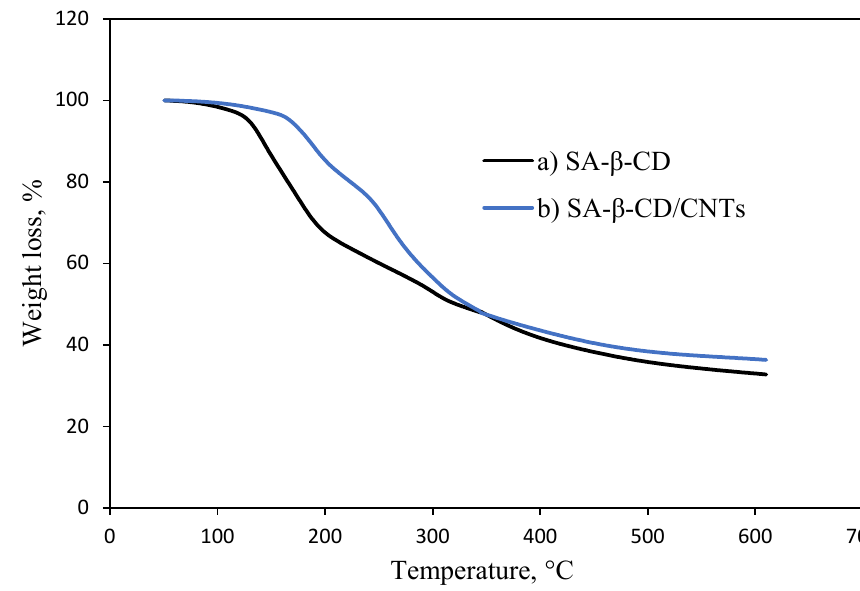
Figure 5. Thermogravimetric analysis of (a) SA − β − CD and (b) SA − β − Figure 5 . Thermogravimetric analysis of (a) SA −β− CD and (b) SA −β− CD/CNTs.